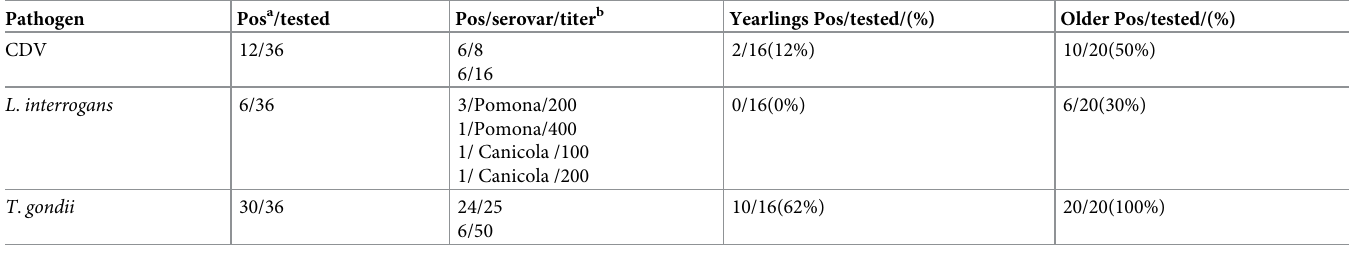
Table 1. Frequencies and antibody titers detected in sampled Caspian seals by age class.